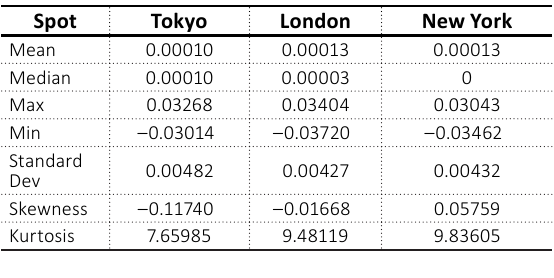
Table 1. Summary statistics of daily gold returns in Tokyo, London, and New York